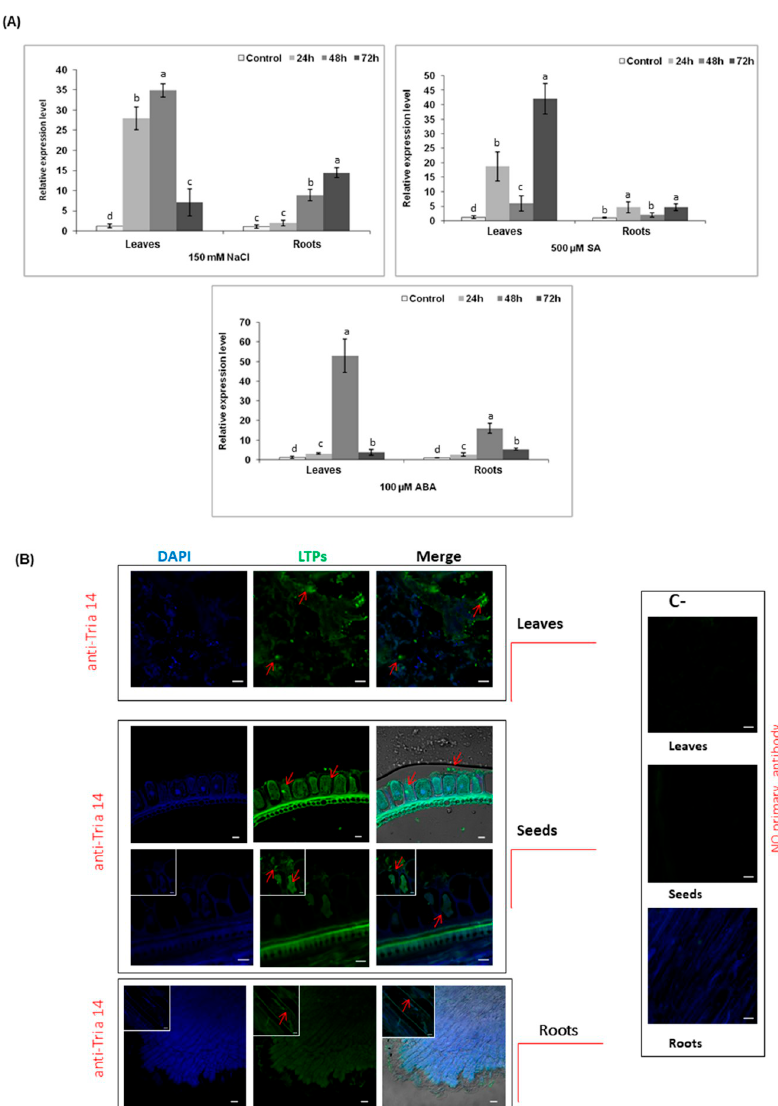
Fig 3. Expression profiling by QRT-PCR of TdLTP2 and immunolocalization of nsLTPs in Triticum durum . (A) QRT-PCR in roots and leaves tissues from durum wheat exposed to different stress conditions (150 mM NaCl, 100 μ M ABA and 500 μ M SA). The mock control was treated with water solution. Results were shown as means ± standard deviation of three biological replications. Relative gene quantification was calculated by the comparative Ct method. Data were normalized to the expression level of the wheat gene factor CDC (GenBank accession no. Ta54227). (B) Immunolocalization of nsLTPs sections from leaves, roots and seeds fixed with paraformaldehyde 4% and incubated with Alexa 647-labeled LTPs. LTPs detected with anti-Tri a 14 antibody (green) have been added. DAPI (blue) was used as control. Bar: 10 microns. The probability (P) value < 0.05 was used to measure the significant change with unequal